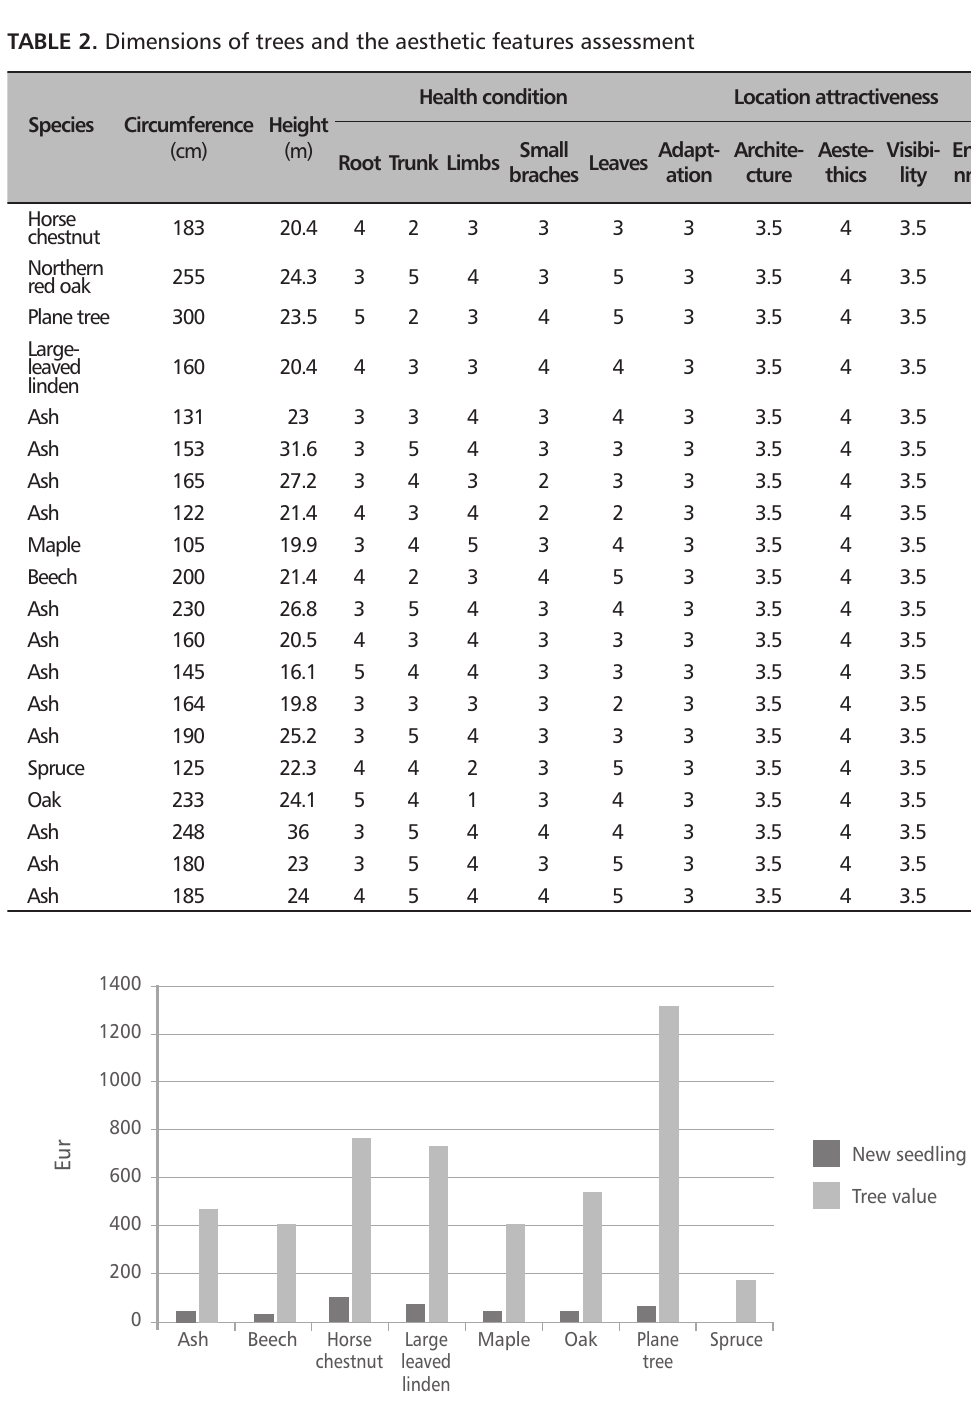
FIGURE 1. The comparison of average thee